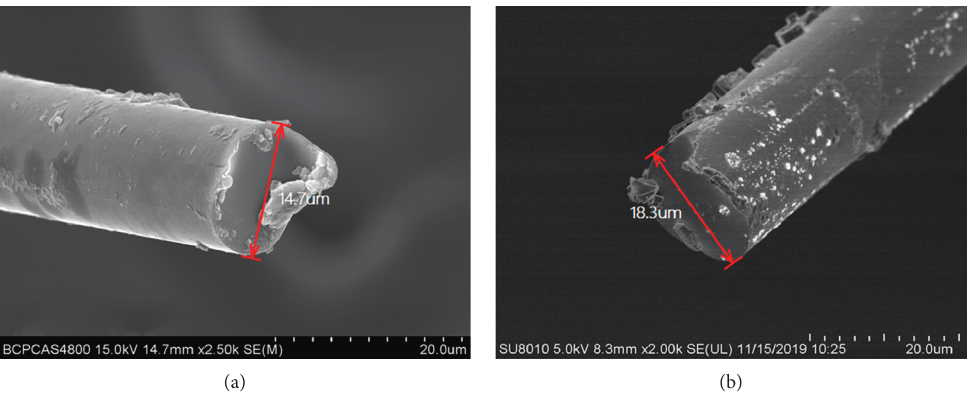
Figure 8: Diameter of basalt fiber (a) before and (b) after immersion in sea